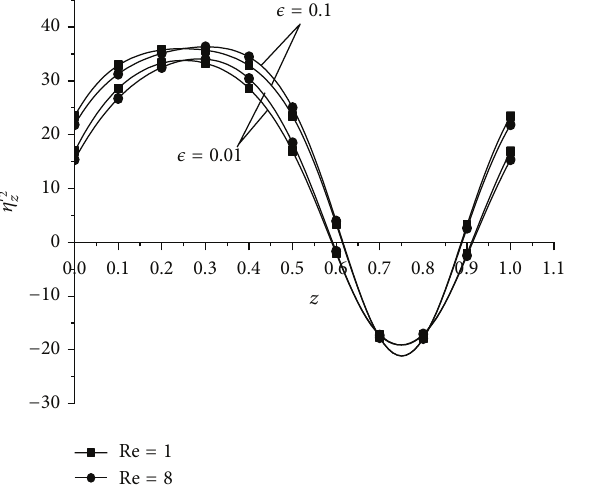
Figure5:Variationofwallvorticity 𝜂 𝑟 2 𝑧 versus 𝑧 withdifferentvalues of 𝜖 and Re at Wi = 0.01 , 𝛿 = 0.1 , 𝑄 = 1 , and 𝜙 = 0.4 .